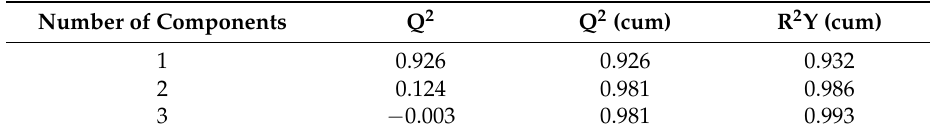
Table 5. Extracted components and the corresponding cross-validation of PLS model.